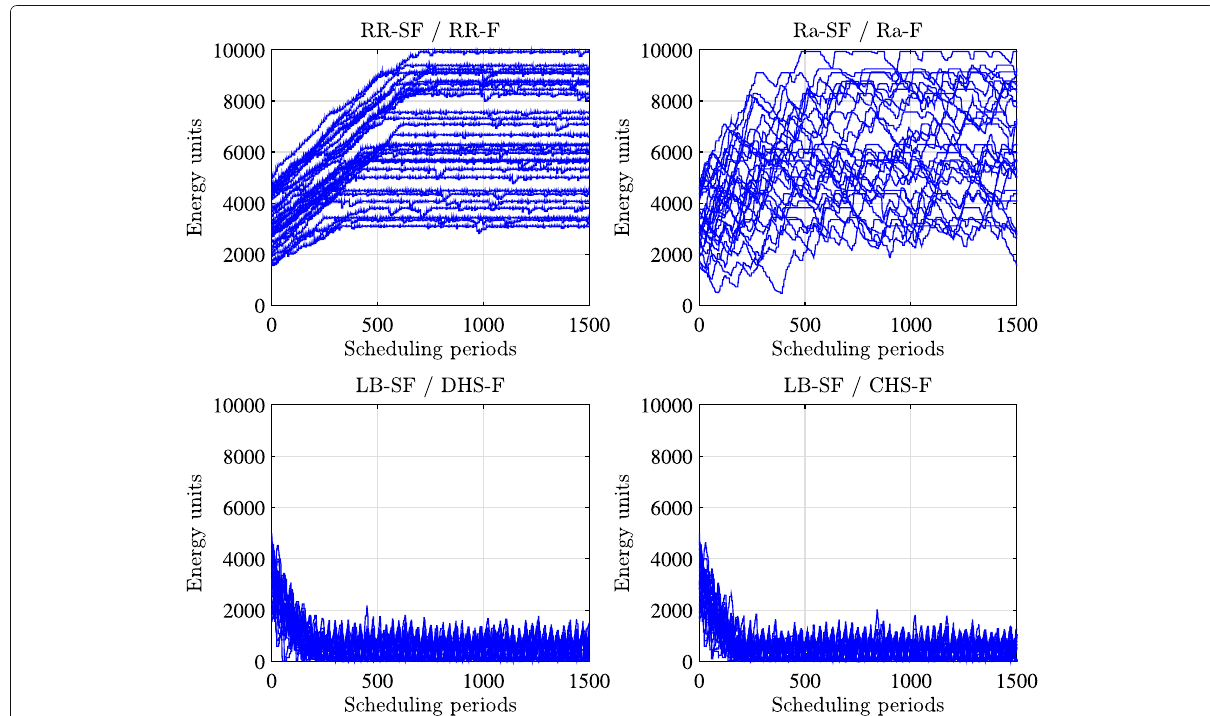
Fig. 4 Time evolution of the battery levels. Time evolution of the battery levels of all users in the system for the different approaches